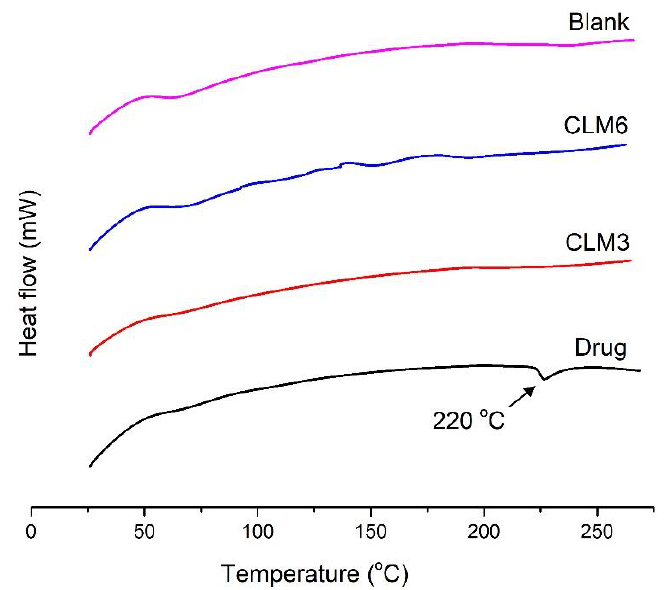
Figure 8. DSC thermogram of blank, CLM3 and CLM6 microbeads, and clarithromycin.